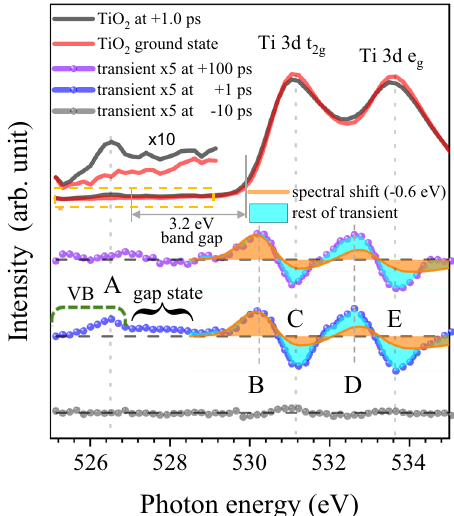
Fig. 3 Femtosecond transient-absorption spectroscopy of TiO 2 NC at the oxygen K-edge. XAS spectra measured + 1 ps after pump excitation (black) and ground states before excitation (red). Transient XAS are obtained at + 1 and + 100 ps time delays. The transient XAS was obtained from the difference between the optically excited XAS at several pump-probe time delays and XAS measured at a negative time delay of − 15 ps (ground state). Errors for the transient XAS were estimated from the transient XAS at a negative delay time ( − 10 spectra were recorded at 1, 100, and − 10 ps with a 266 nm optical pump laser; apparently signi fi cant features in the transients are indicated as A – E. Feature A and the gap state show relatively fast decay within 100 ps, whereas the other features of B-E remain almost unchanged until 100 ps. Peak A and the indicated gap states (Fig. 3) can be assigned to holes in the oxygen 2p valence band (VB) and localized defect sites, respectively. The features B-E result from energy shifts of the excited states with respect to the ground state, which is evident from the subtraction of ground state spectrum from the shift (by − 0.6 eV) of the whole spectrum.